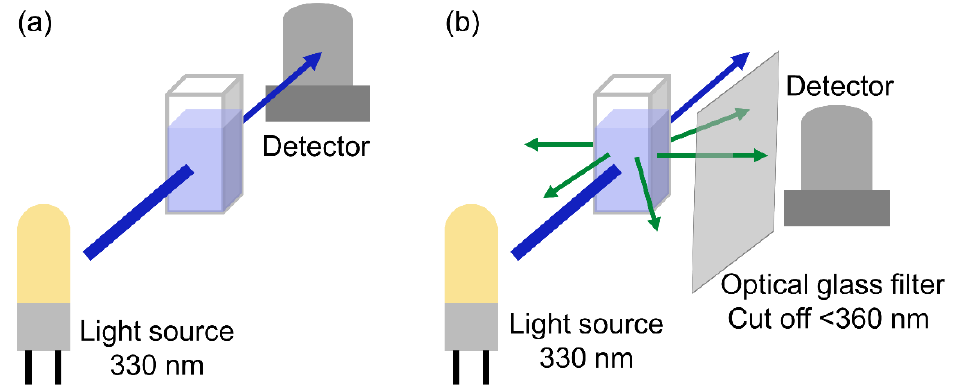
Figure 7. Conceptual drawing of the construction of meter for absorbance measurement ( a ) and fluorescence measurement ( b fluorescence measurement ( b ).